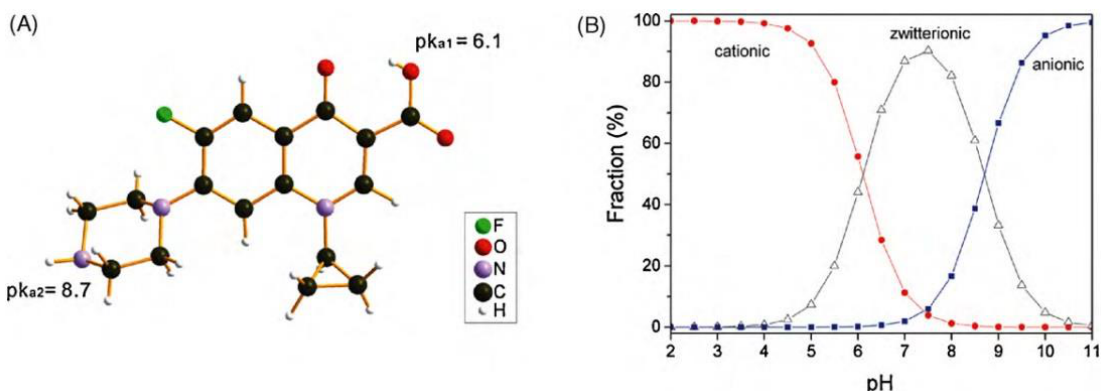
Fig. 5: A) Molecular structure of ciprofloxacin, B) ionizing forms of ciprofloxacin at different pH (Wang et al.,